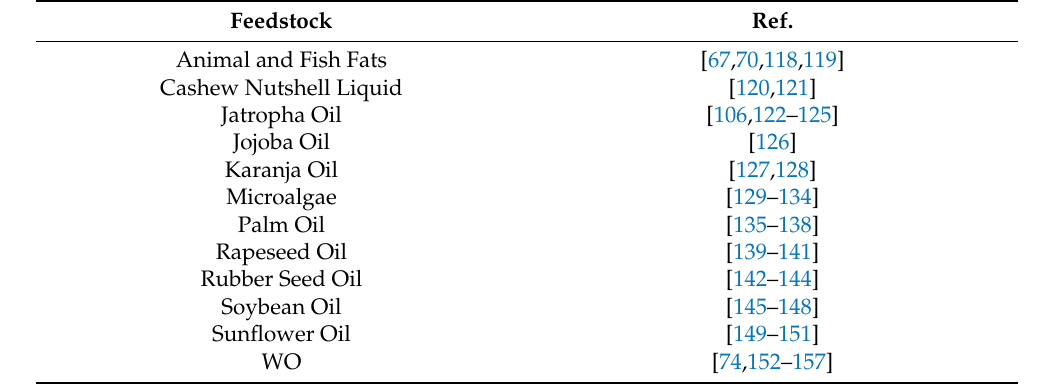
Table 2. Feedstock used for green diesel production; data adapted from sources in the “Ref.” column.